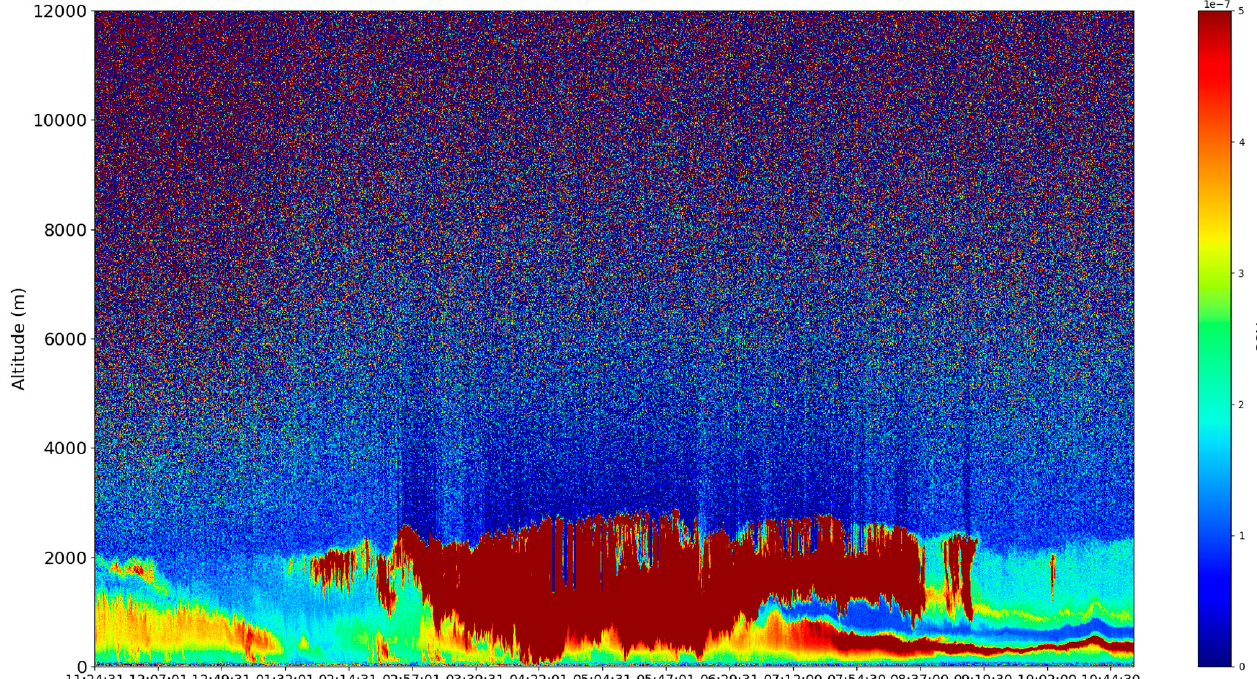
Figure 13. RCS time series, λ = 1064 nm , Gala ț i, Romania, 23 December 2021.